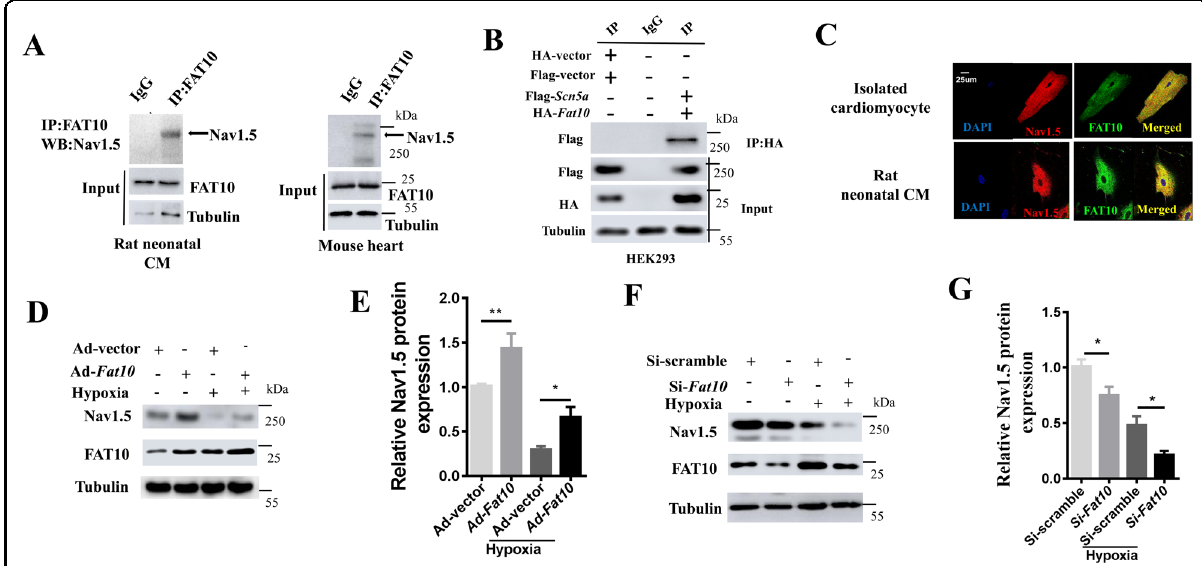
Fig. 4 FAT10 regulates Nav1.5 protein expression in cardiomyocytes. A Coimmunoprecipitation (Co-IP) was performed to elucidate the association between FAT10 and Nav1.5 in neonatal rat cardiomyocytes (NRCMs) (left) and mouse hearts (right). B The association between FAT10 and Nav1.5 in HEK293 cells expressing Flag-Nav1.5 and HA-FAT10 was detected by Co-IP. C Photomicrographs showing the colocalization of FAT10 and Nav1.5 in cardiomyocytes (upper) and NRCMs (lower). D , E Effect of FAT10 overexpression on Nav1.5 expression levels in NRCMs under normoxic and hypoxic conditions as evaluated by WB (* p < 0.05, ** p < 0.01). F , G Effect of Fat10 knockdown on the Nav1.5 expression levels in NRCMs under normoxic and hypoxic conditions as evaluated by WB (* p < 0.05, ** p < 0.01). All results are expressed as the mean ± SEM of independent